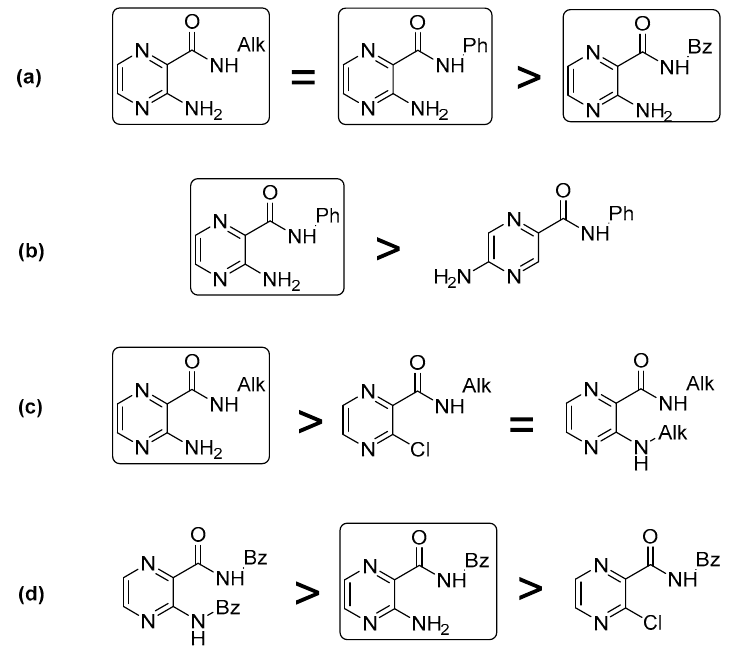
Figure 3. A comparison between antimycobacterial activity against Mtb ( a ) between the three structural subtypes of the current series ( b ) between phenyl derivatives belonging to this series and their positional isomers [16] ( c ) among different alkyl derivatives [14] ( d ) among different benzyl derivatives [15]. Structures in rounded rectangles belong to the current series. Alk = alkyl; Ph = phenyl; Bz = benzyl. Structures in rectangles belong to the current series.